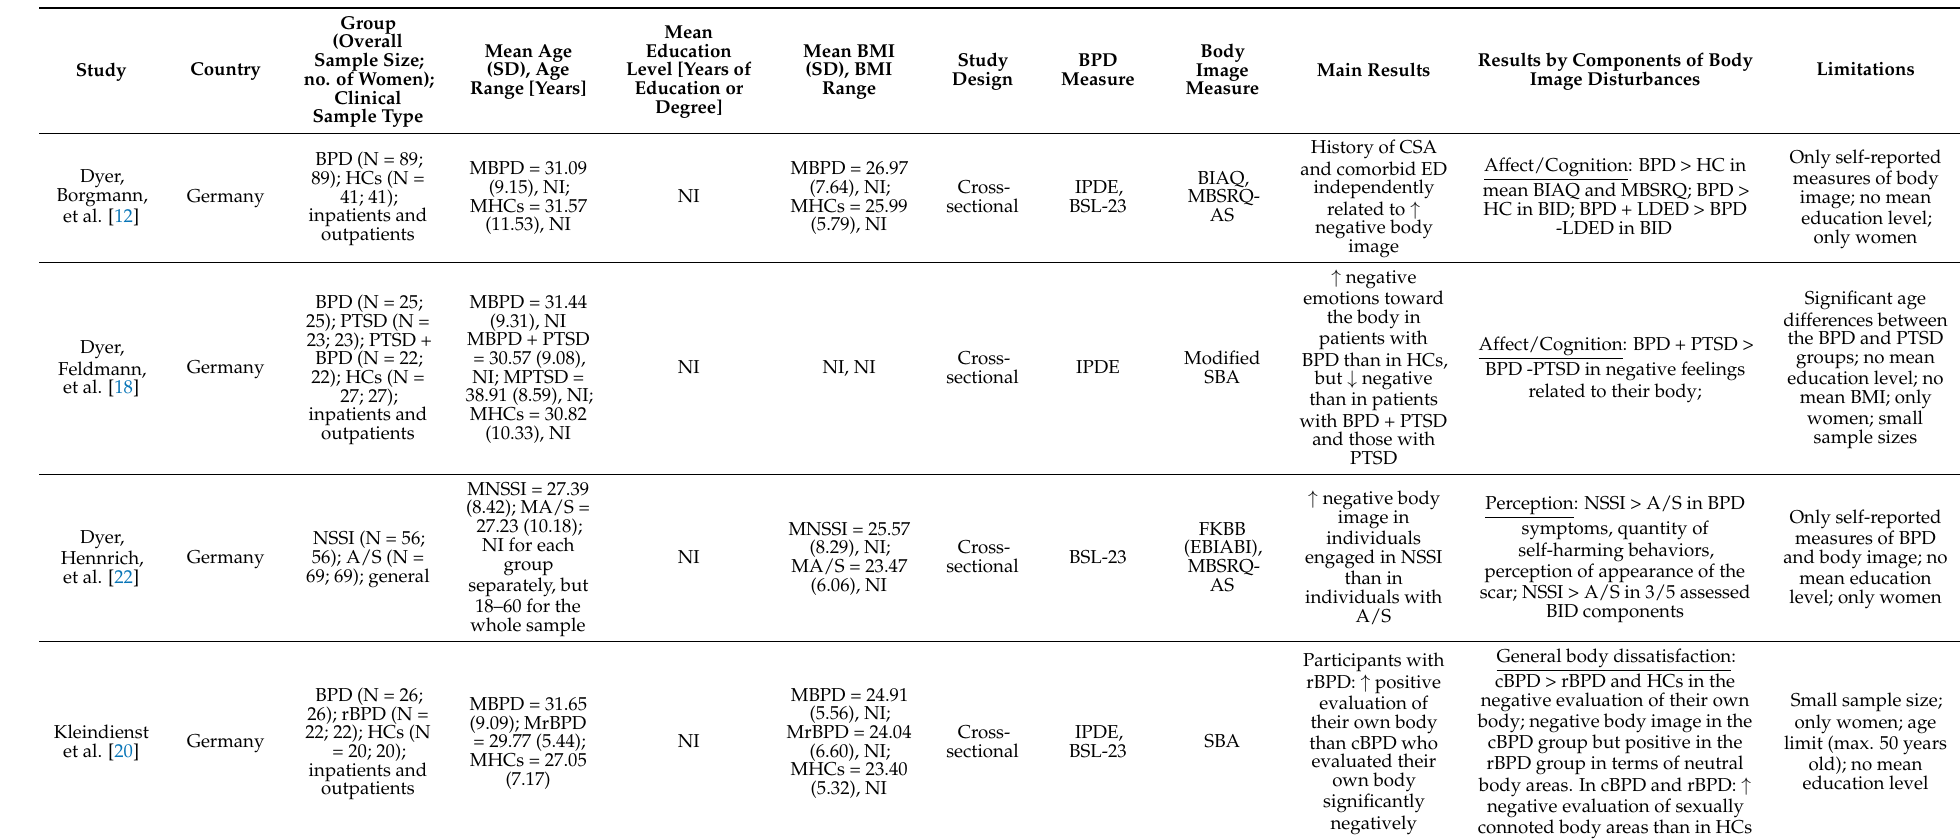
Table 1. Characteristics of the reviewed